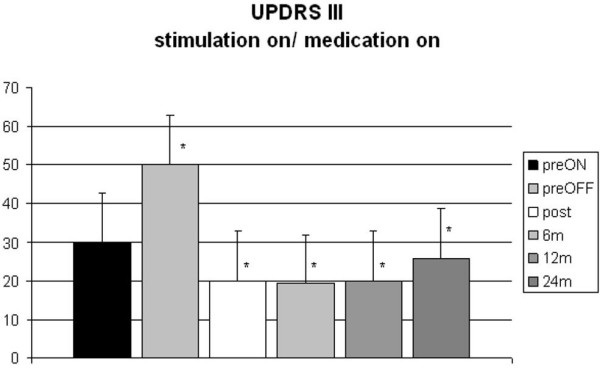
UPDRS motor scores (part III) in all patients before surgery (with/without medication) and at postoperative follow-up after 6, 12, and 24 months (preoperative medication on – preON, preoperative medication off: preOFF, postoperative stimulation on and medication on).